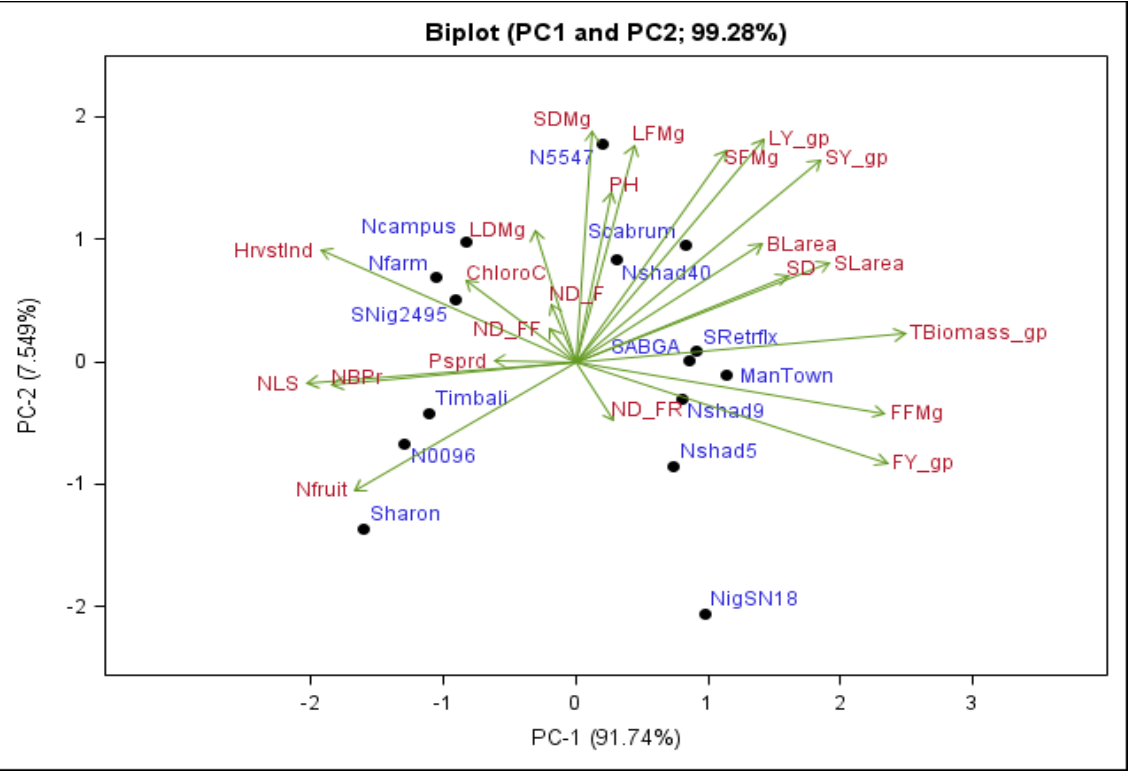
Figure 1. Principal component analysis biplot describing the overall variation among nightshade accessions estimated using 22 traits. PC—principal components 1 and 2. Black dots show the position of accessions in the quadrant and vector lines show how a trait influences the grouping of accessions.